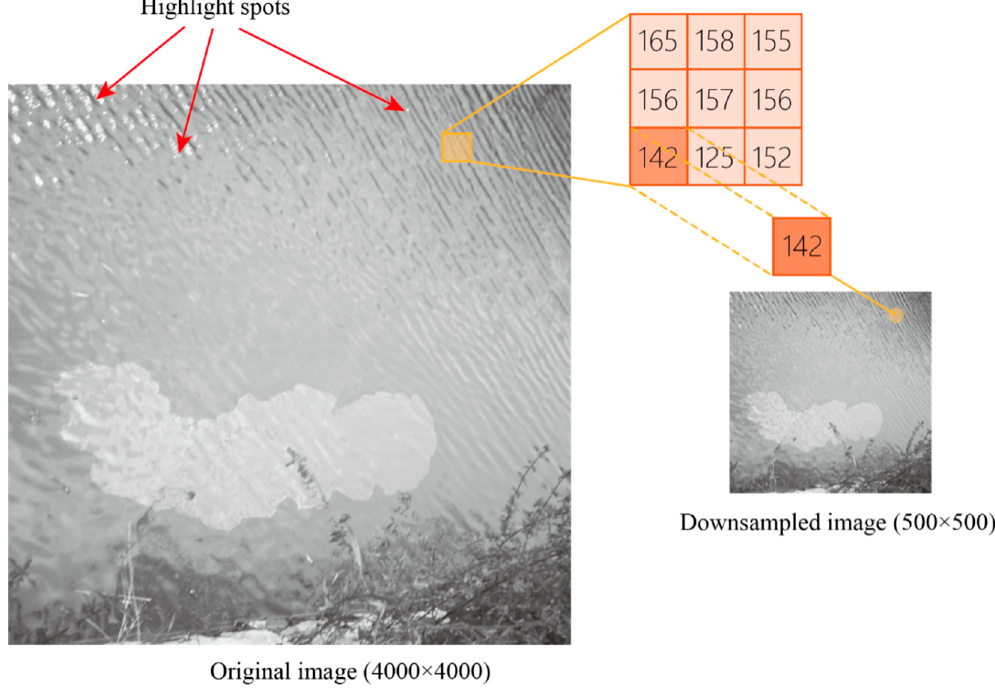
Figure 2. An example of the grid cell analysis (GCA) process.